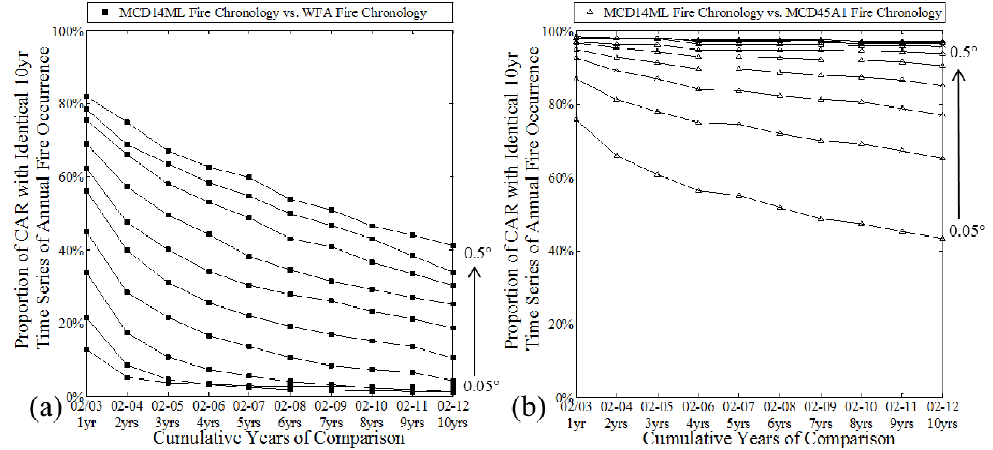
Figure 7. Comparisons between fire chronologies derived from ( a ) the active fire (AF) datasets (MCD14ML and WFA); and ( b ) the MODIS AF dataset (MCD14ML) and the MODIS burned area (BA) dataset (MCD45A1). Comparisons are based on the proportion of grid cells in the CAR where both fire products recorded an identical 10 yr time-series of annual fire occurrence (e.g., see Table 1 for an example of a fire chronology in a single grid cell). Results demonstrate that the agreement between fire chronologies improves for coarser grid cell resolutions, but diminishes as the number of years included in the time-series